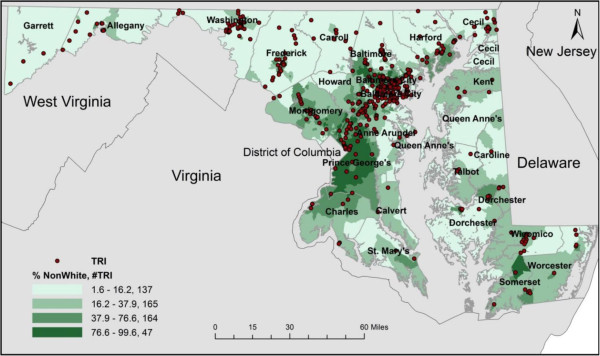
Choropleth Map of TRI Facilities in Maryland by Quartiles for Percent Non-White (2010 US Census).